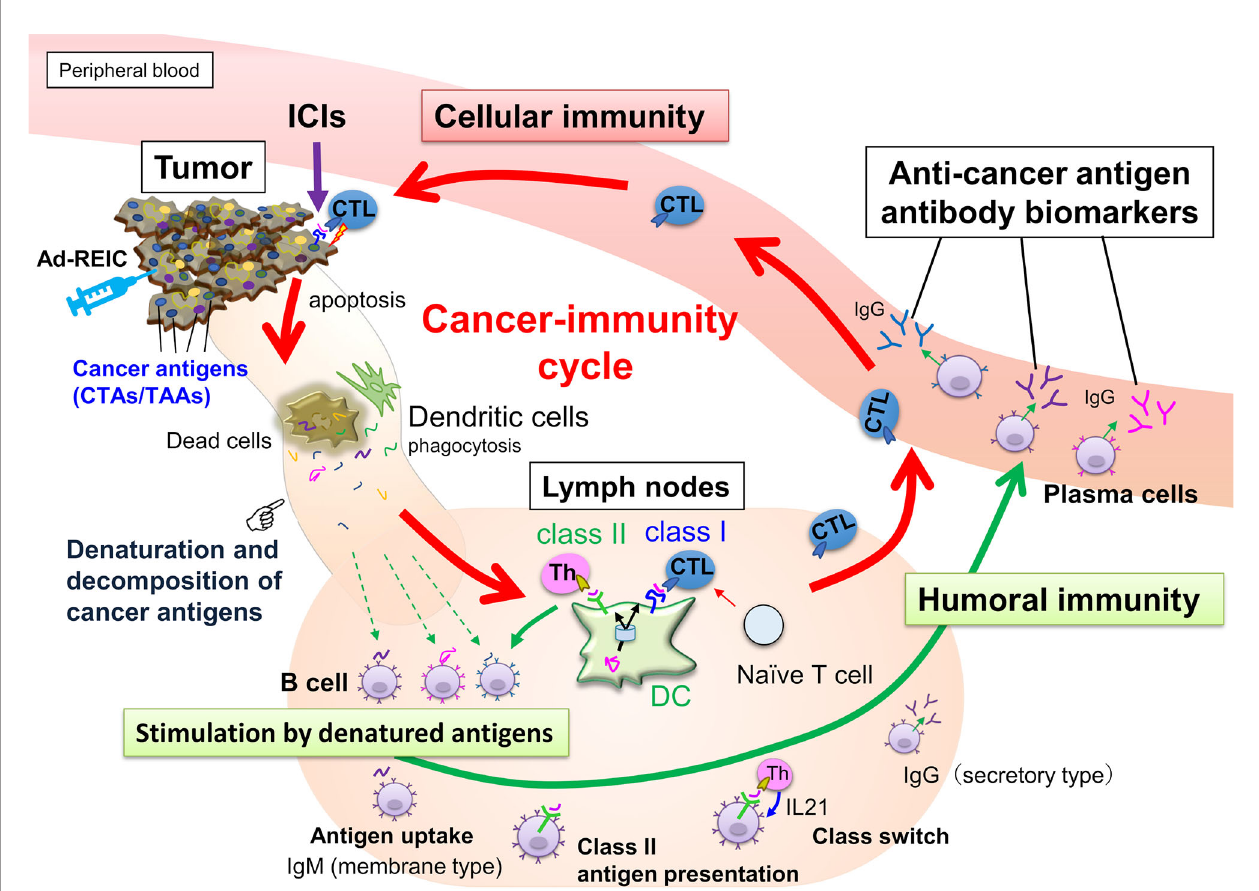
FIGURE 1 | Anticancer immunity is enhanced by the cancer-immunity cycle, and cytotoxic T-lymphocytes (CTLs) eliminate cancer cells. Along with activating the cancer-immunity cycle, antibodies against cancer antigens upregulate by stimulation of released antigens from the cancer cells. Most intracellular cancer antigens suggest easy to denature and decompose after release from cancer cells due to their unstable physical properties. Antibody-producing cells that bind to denatured cancer antigens proliferate, so anti-cancer antigen IgGs recognizing the amino acid sequence of linear epitopes increase